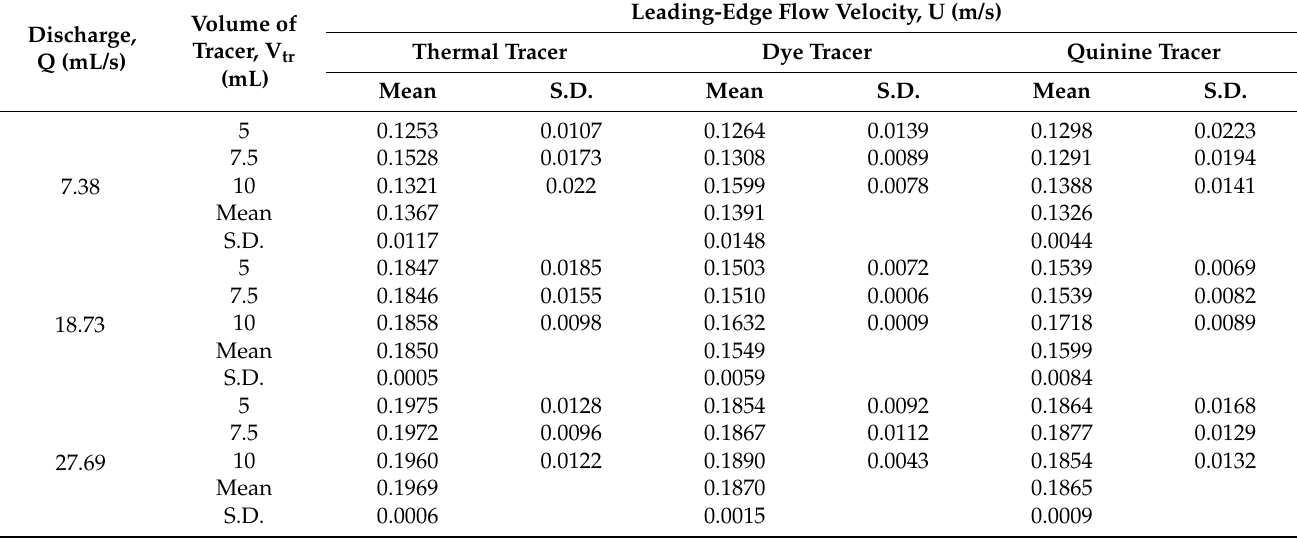
Table 3. Rill flow test results for thermal, dye and quinine fluorescent tracer leading-edge velocities, for different discharges and tracer volumes. The data are for three replicates of each combination.